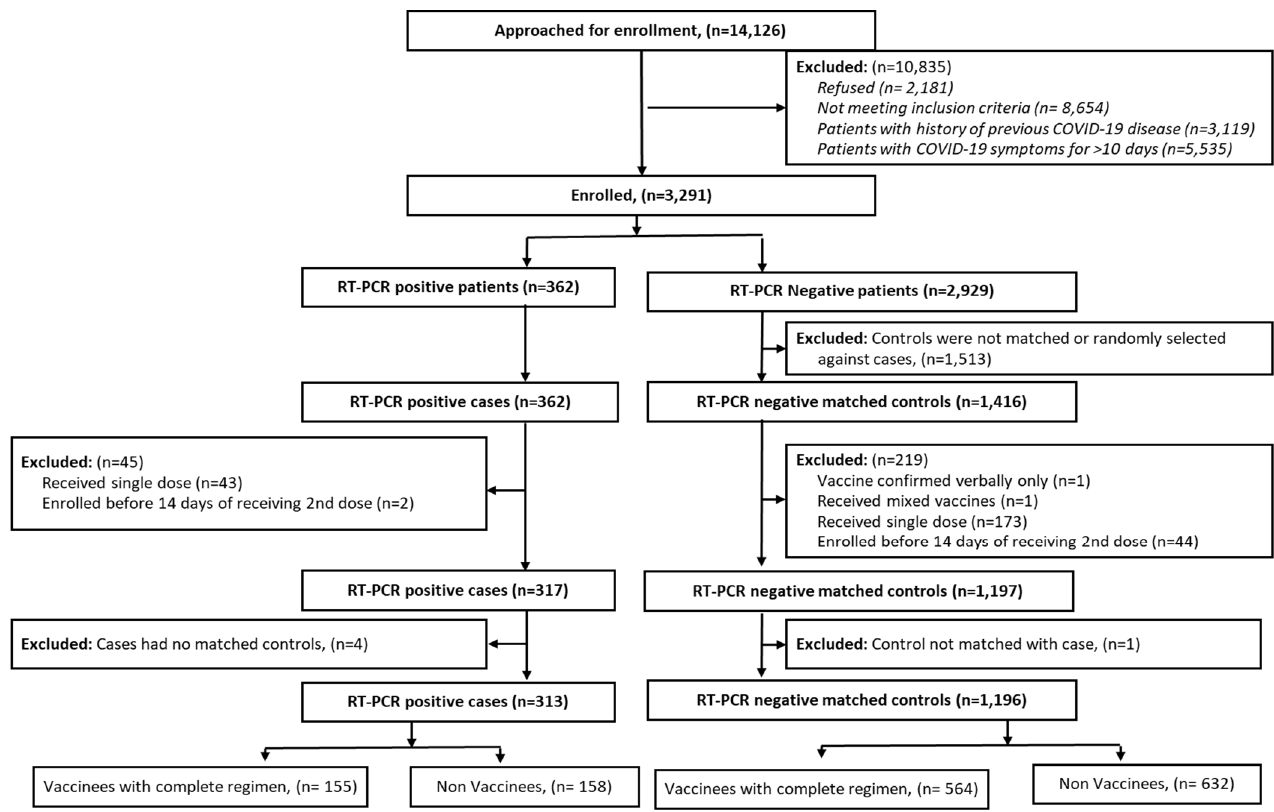
Figure 1. CONSORT diagram for the assembly of the study population.